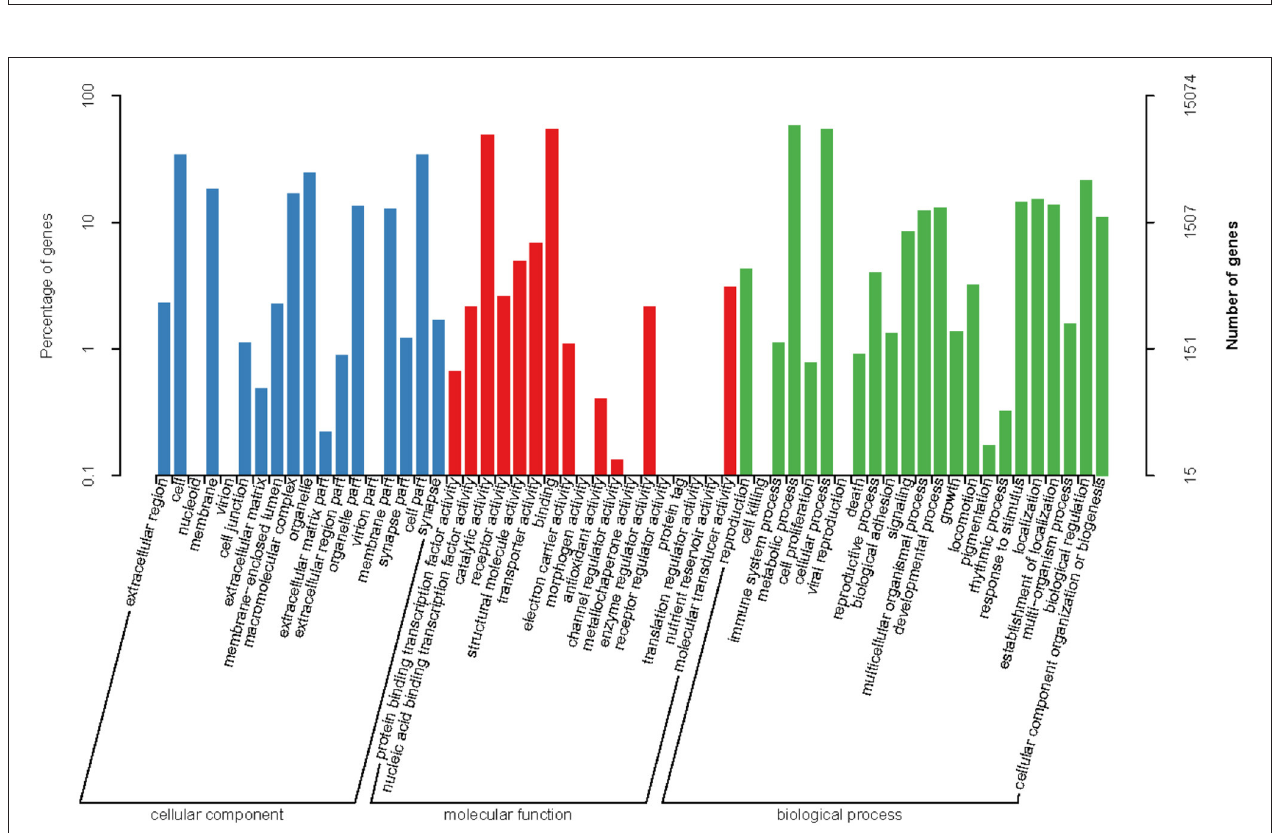
FIGURE 2 | Functional annotations of assembled sequences based on gene ontology (GO) categories.